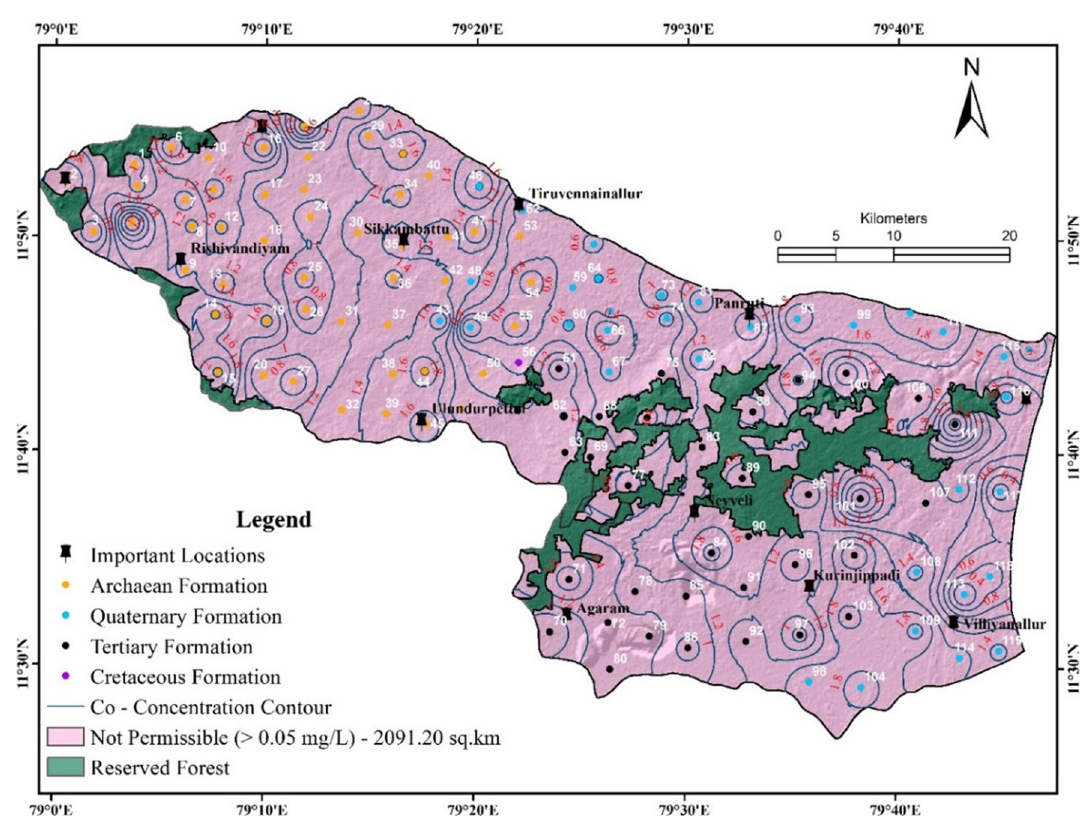
Fig. 10 Spatial variation with contour map of cobalt in